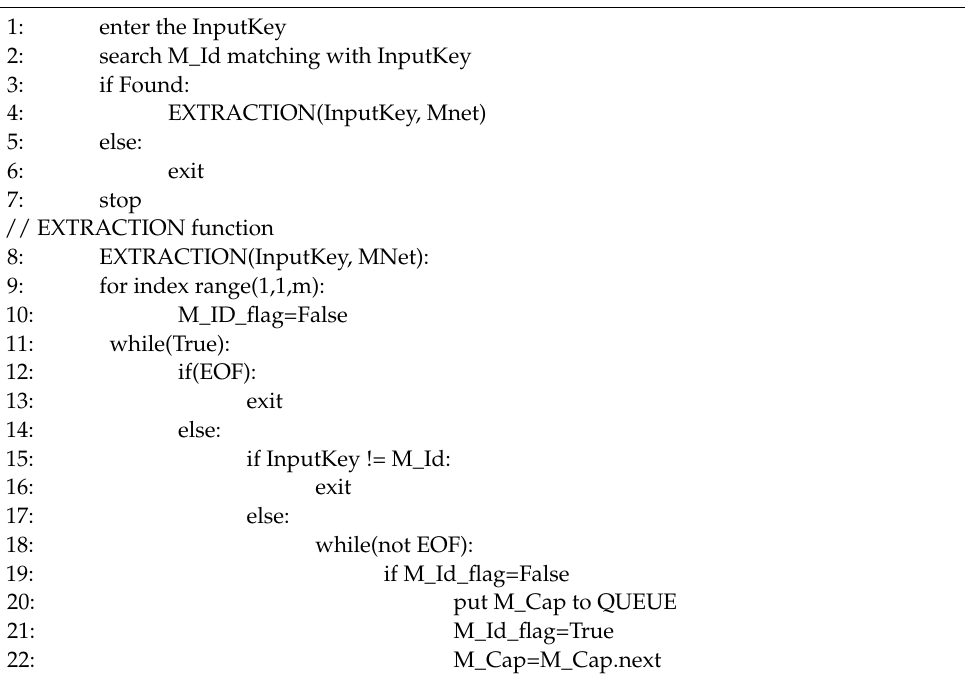
Algorithm 1: Thinking Thread